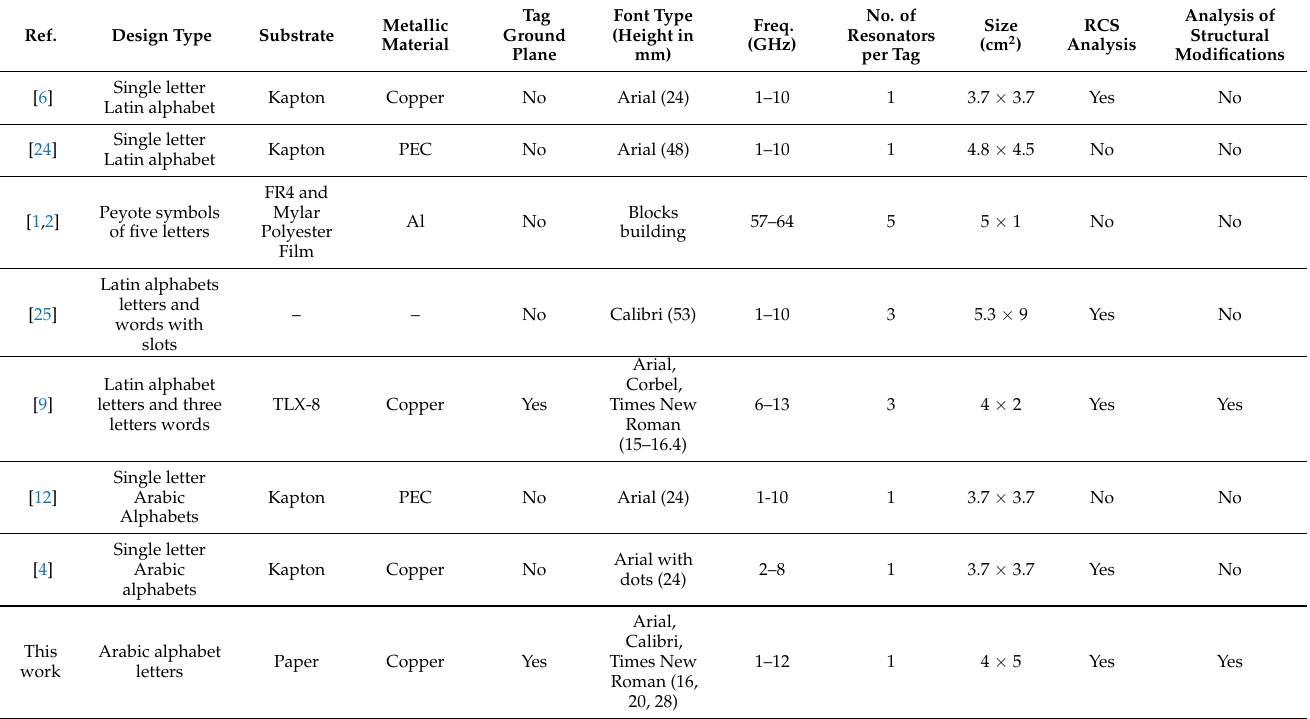
Table 12. Comparison of the proposed design of printable chipless RFID Arabic letter tags design with legacy